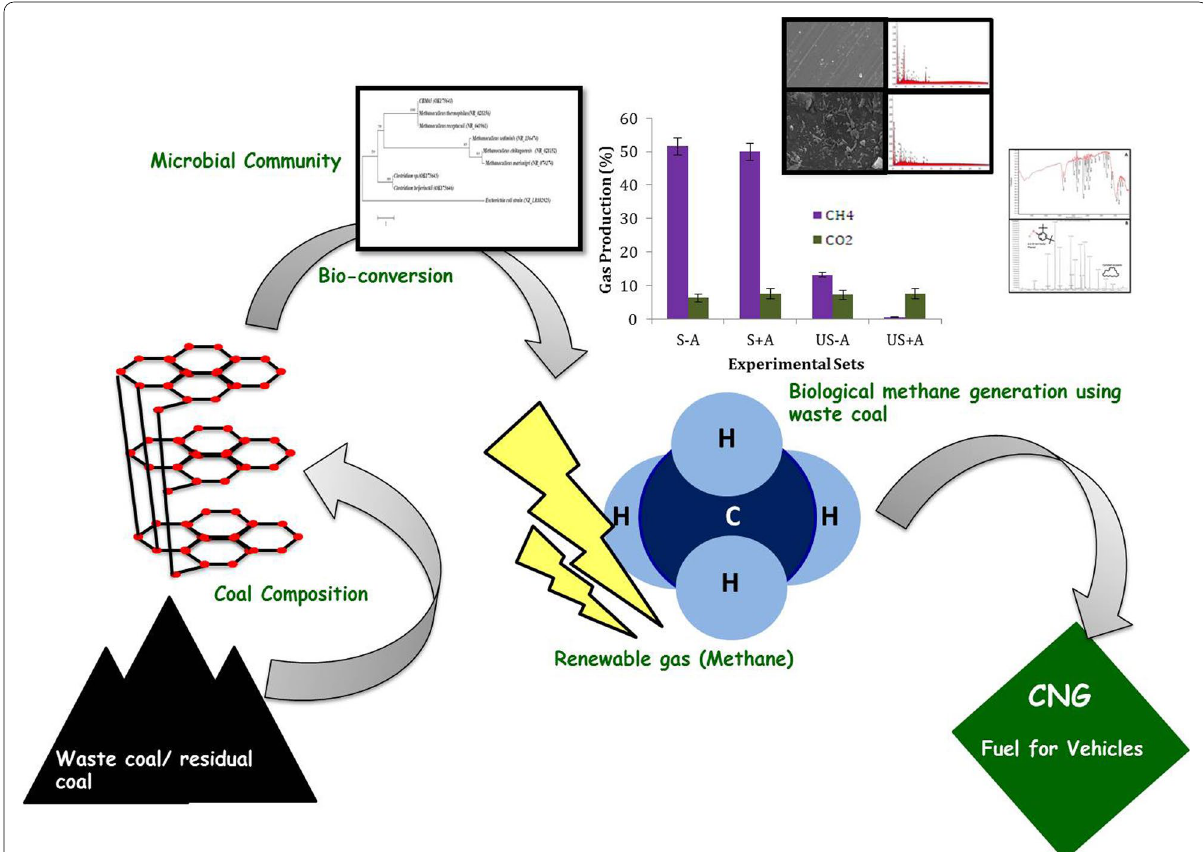
Fig. 2 Schematic demonstrations of bio-conversion process of microorganism interactions with coal and generation of